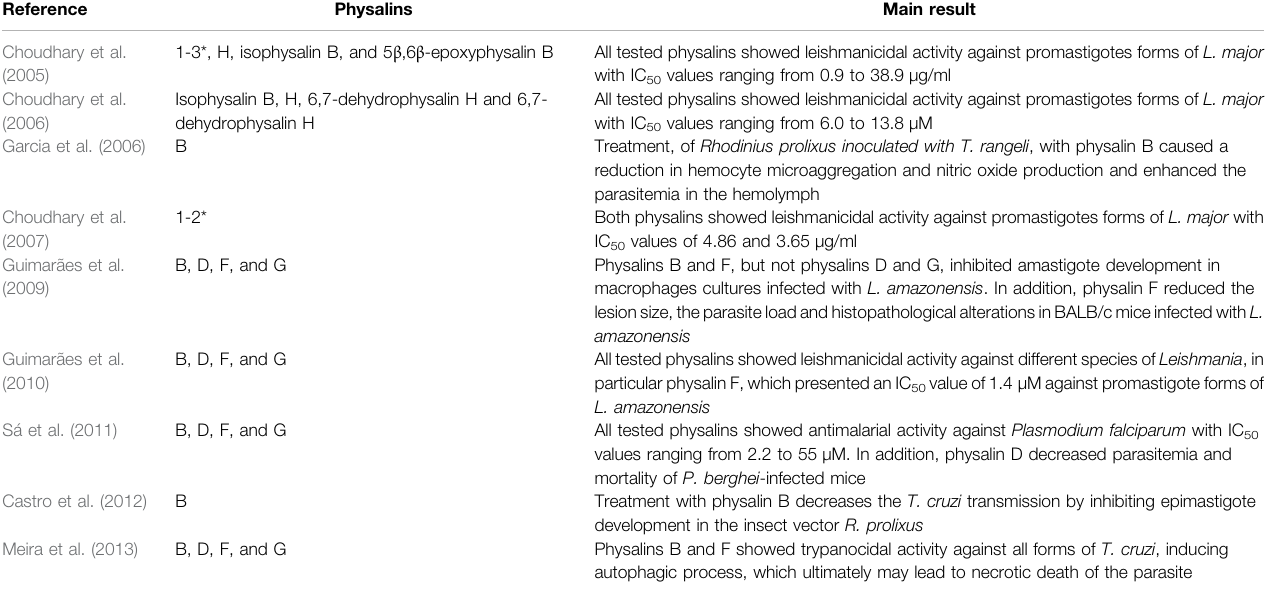
TABLE 3 | Antiparasitic activity of